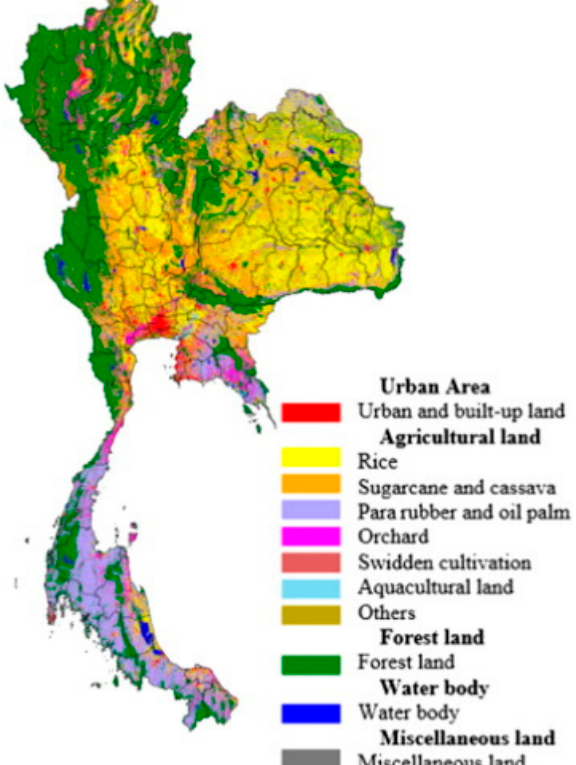
Figure 1. Agricultural regions in Thailand.